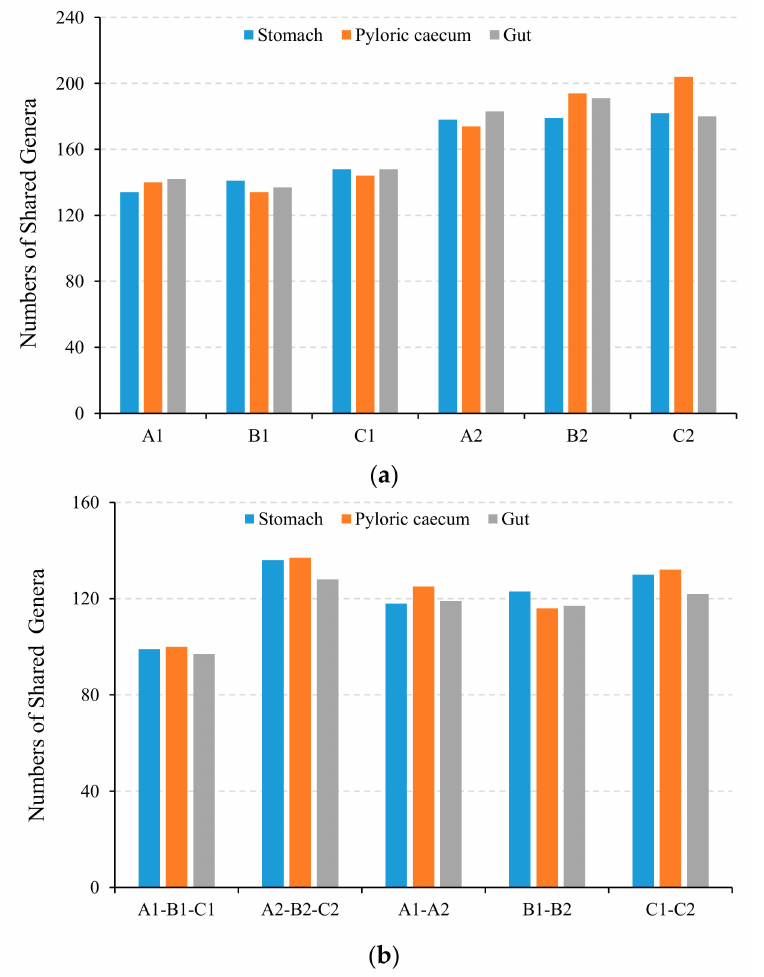
Figure 7. The shared genera of each tissue of yellowtail kingfish. Notes: ( a ) among the three parallel groups of each density group; ( b ) among three different density groups at the beginning or end of the study, and between the beginning and end of the study for each density group. A1, B1, and C1 represent the low-, medium-, and high-density groups at the beginning of the study, while A2, B2, and C2 represent the low-, medium-, and high-density groups at the end of the